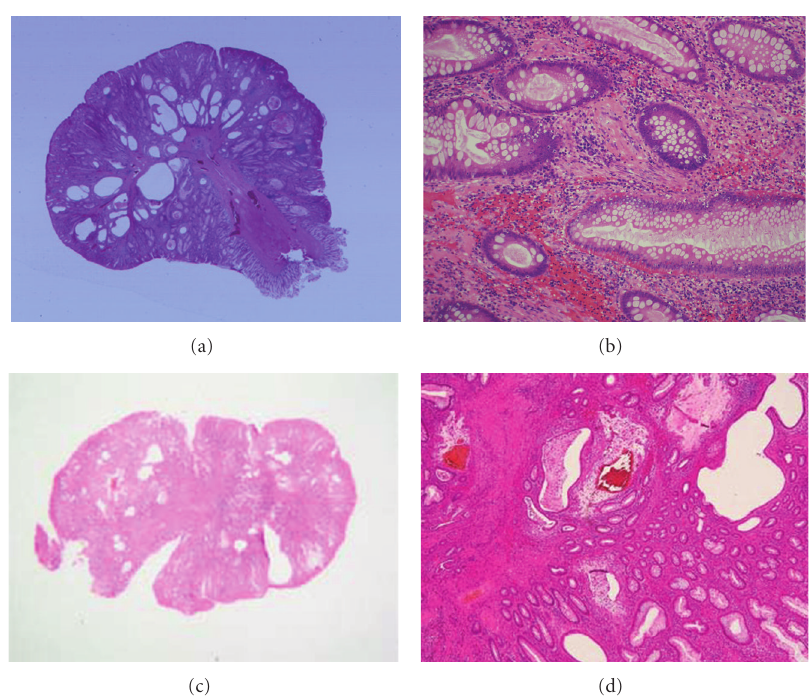
Figure 4: In case 2, histological examination of the specimen revealed hyperplastic glands with variable cystic changes (a), inflammatory granulation tissue in the lamina propria, proliferation of smooth muscle (b). In case 3, (c) hyperplastic glands with variable cystic changes were seen in the superficial portion in the polyp. Inflammatory granulation tissue in the lamina propria and proliferation of smooth muscle were also seen in the resected specimen